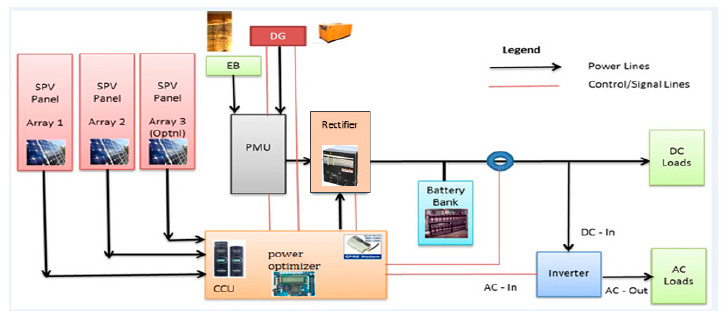
Figure 2. Schematic diagram of a solar hybrid system.